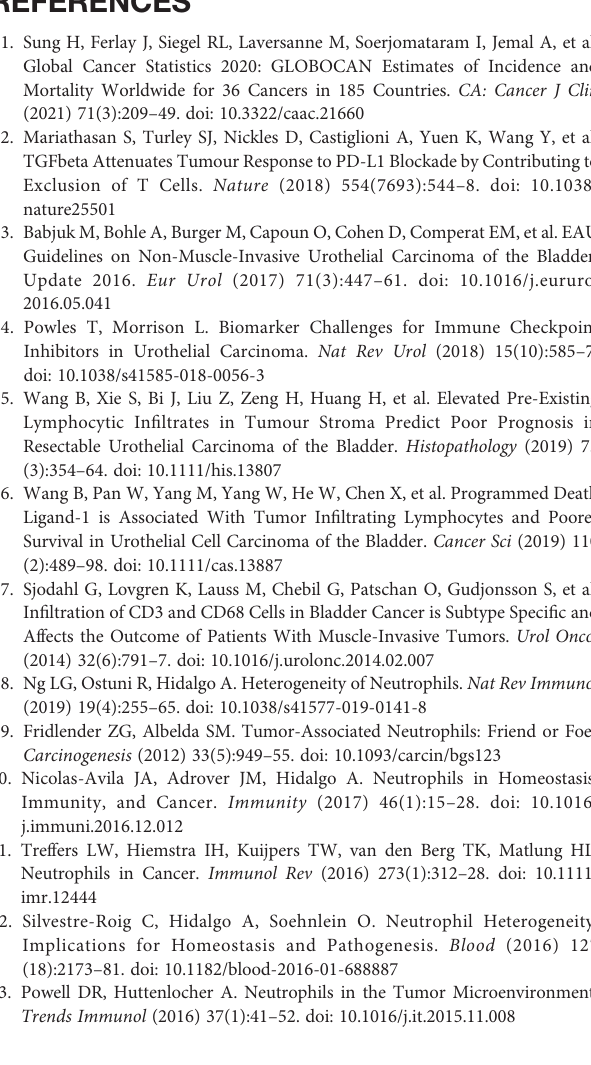
designed as tumor supernatant-treated neutrophils (TTNs). P < 0.05 was Supplementary Figure 4 | Suppression of TTN on T cell immunity through programmed death-ligand 1(PD-L1). (A,B) Consecutivesectionswereused forthe immunohistochemical identi fi cation of stromal CD66b + cells and exhausted T cell makers(PD1)inUCBtissues(n=57).Representativeexamplesoftumorswitheither low (left) or high (right) expression of neutrophil (CD66b), exhausted T cell makers (PD1) markers are shown. Scale bar: 100 m m. P < 0.05 was considered signi fi cant difference (Spearman ’ s rank correlation coef fi cient test). (C – E) In all experiments, autologous T cells were puri fi ed from PBMCs, stimulated with plate-bound anti- CD3/CD28 Abs, and cultured with tumor cell line T24 supernatant treated PBNs (TTNs) in the presence or absence of an anti-PD-L1 Ab at a 1:1 ratio for fi ve days. Flow cytometric analysis of autologous T cell proliferation (C) , apoptosis (D) , and IFN- g production (E) in the presence of PBNs, TTNs with or without an anti-PD-L1 Ab. Data shown are from one of six representative experiments in (C – E) . The numbers on the histograms or density plots represented the percentage of T cell proliferation or apoptosis, respectively (C, D) . Numbers in the quadrants indicate the percentage of cells in each quadrant (E)